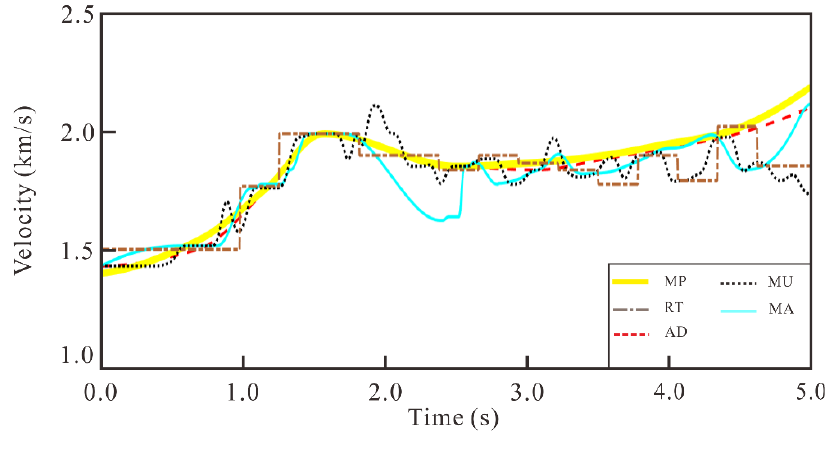
Figure 6. Velocity comparison. Table 2. The difference between the reference and estimated velocities.